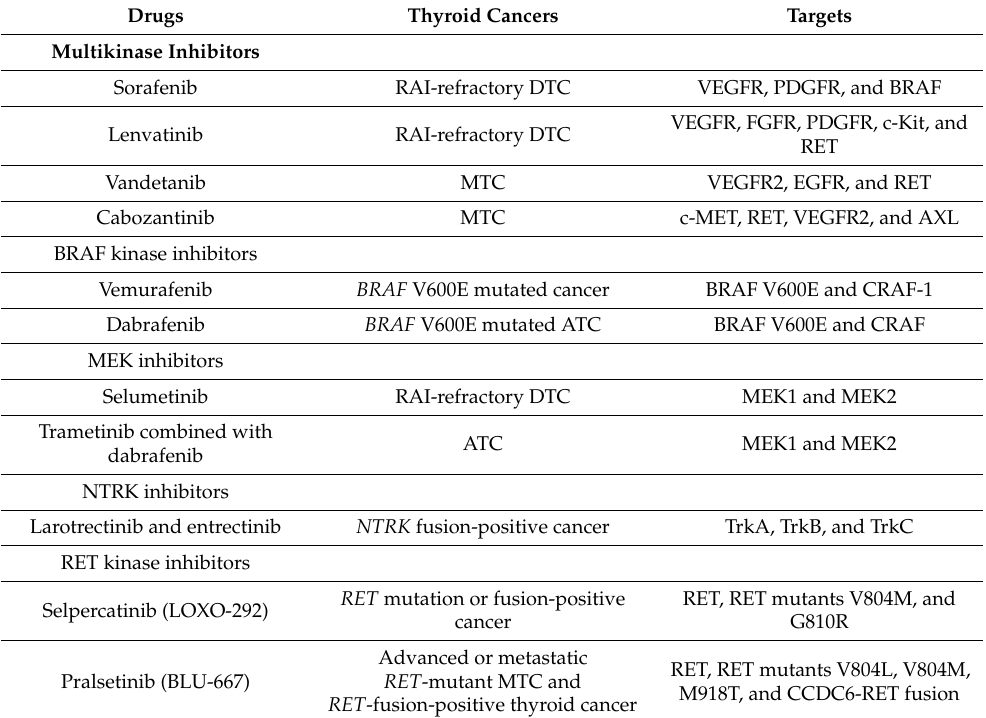
Table 2. Targeted drugs approved by the Food and Drug Administration for thyroid cancer [128].